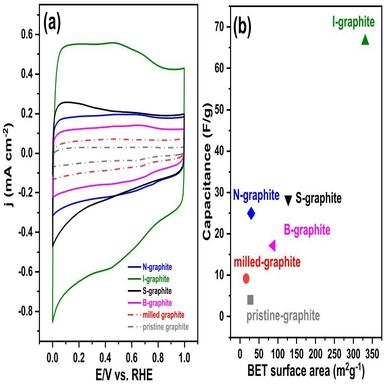
CV profiles of the N-graphite, I-graphite, S-graphite, and B-graphite, pristine graphite, and milled graphite (a) in nitrogen-saturated 0.10 M aqueous KOH solution acquired at a potential scan rate of 50.0 mV s -1. Specific capacitance vs. BET surface area graph (b).